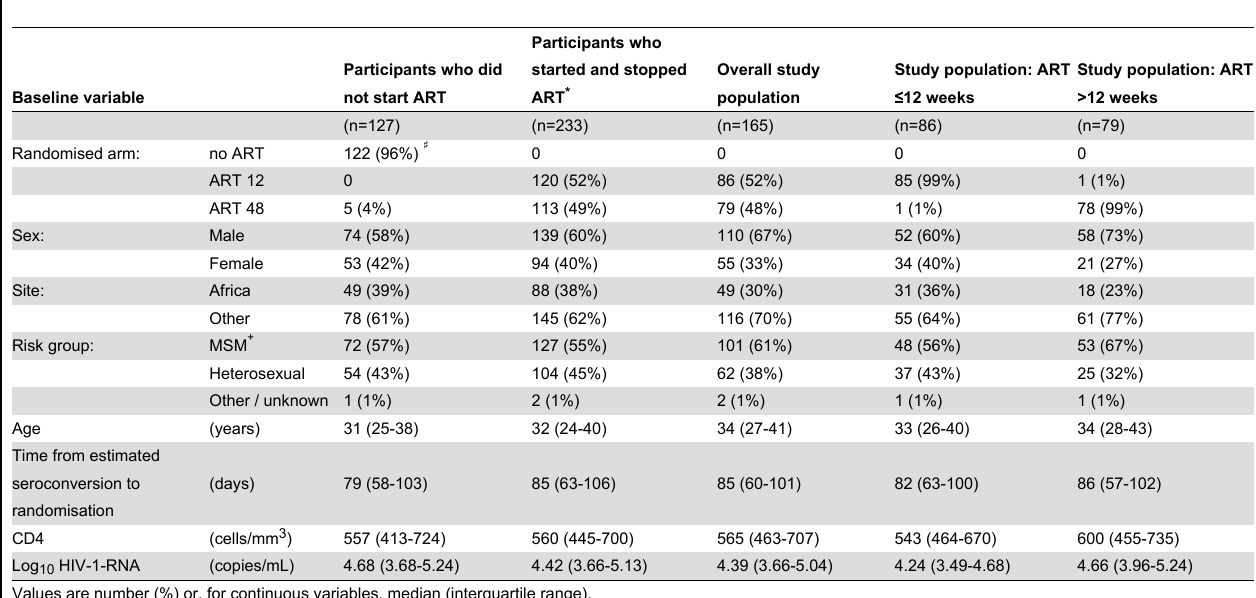
Table 1. Baseline characteristics for participants in SPARTAC analysed in this study.